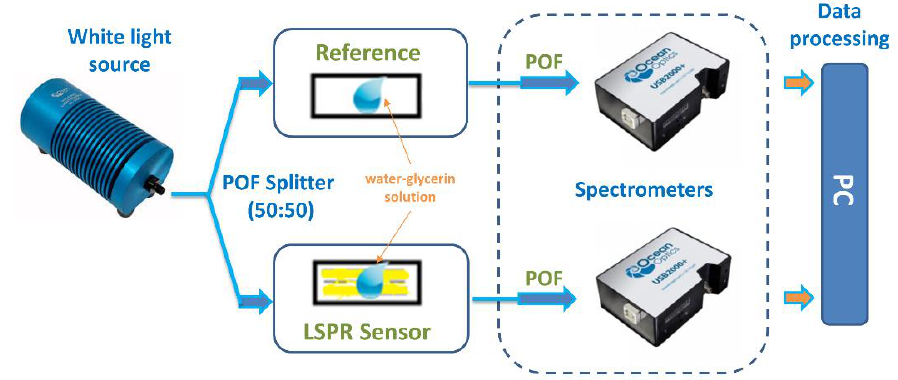
Figure 2. Outline of the experimental setup used to test the plasmonic